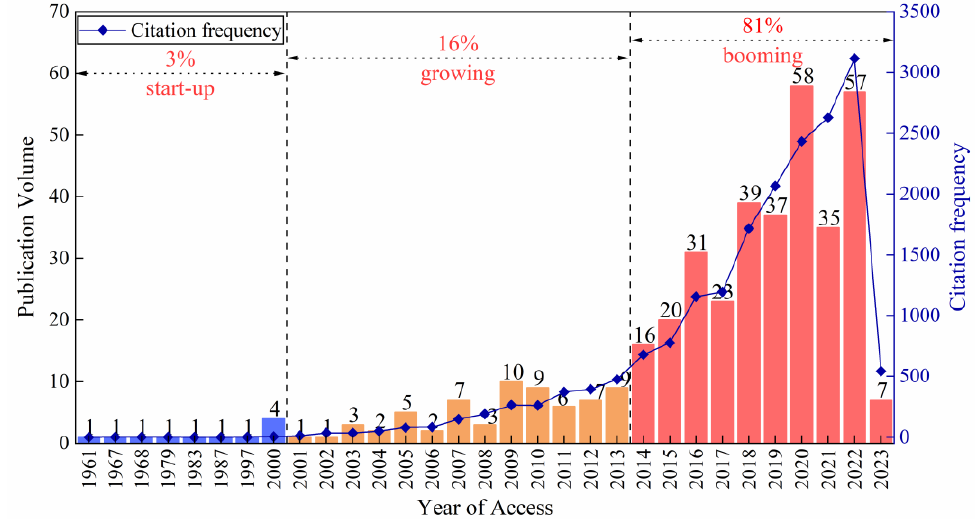
Figure 2. Annual publication volume (including early-access papers) and citation frequency of DAUE.